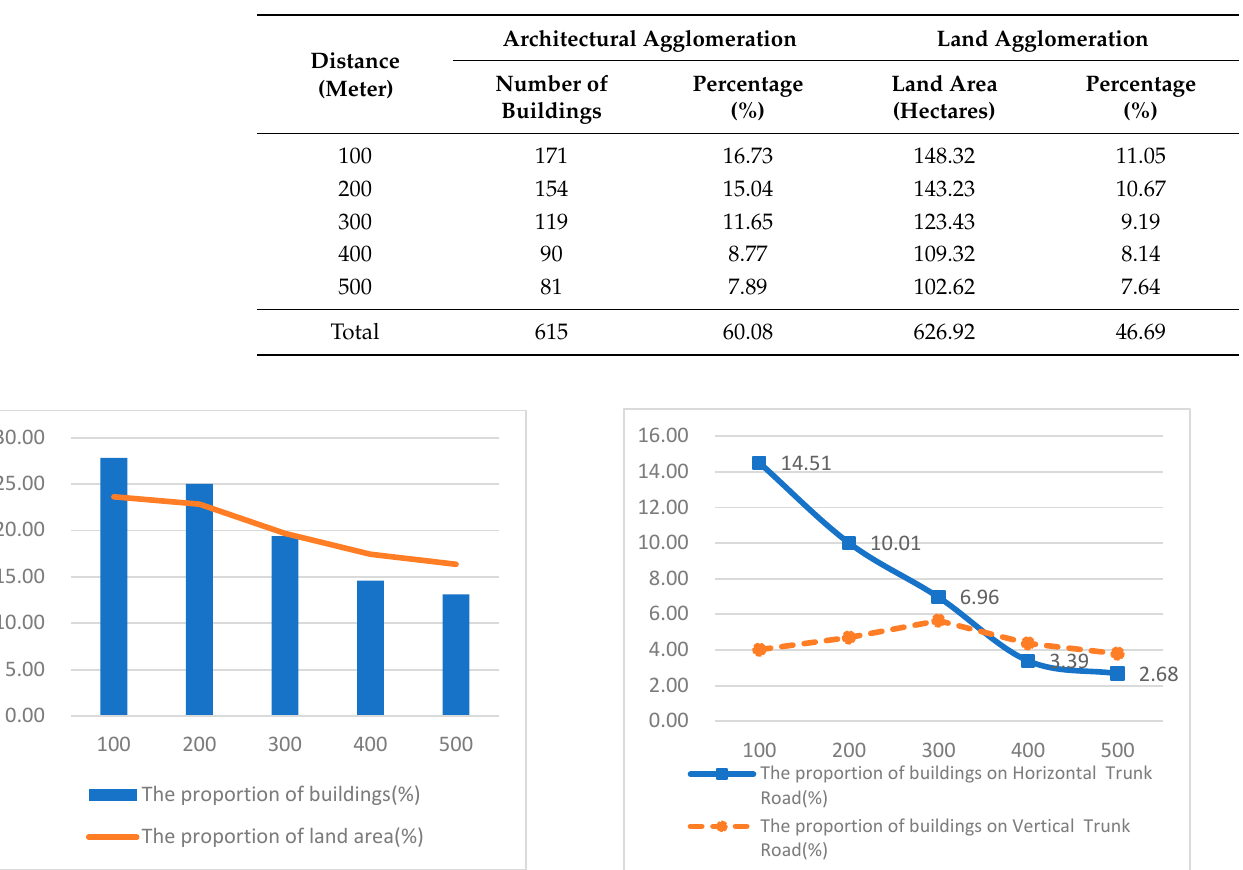
Table 4. Spatial agglomeration of trunk road in the inner fringe.